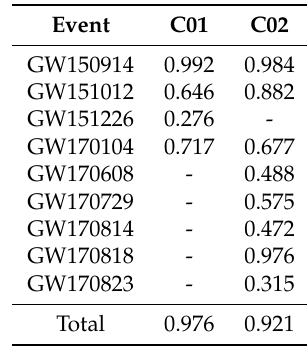
Table 18. Obtained p -values for each event along with total p -value [19]. A hyphen means that 4096-s of data are not available. Data version.